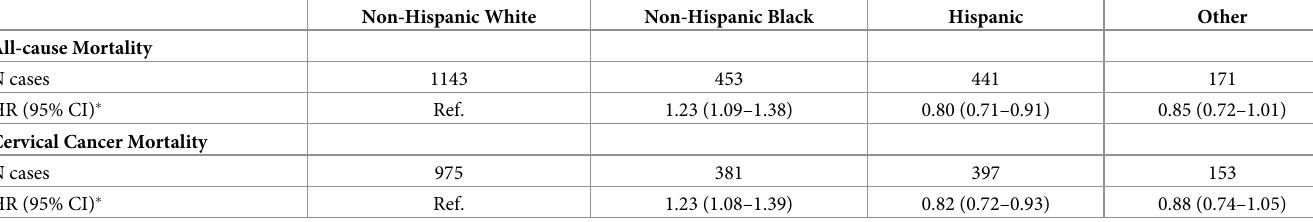
Table 2. Association between race and all-cause and cervical cancer mortality, among women diagnosed with stage I-III disease in SEER